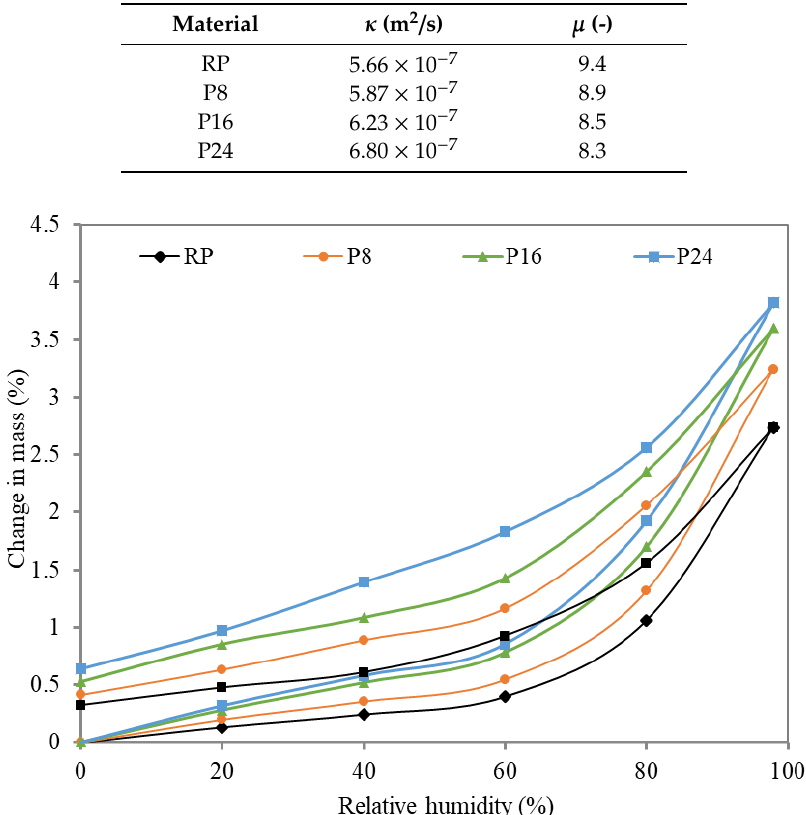
Figure 6. Sorption and desorption isotherms.